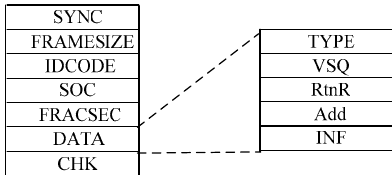
Figure 4. Application extension frame structure.